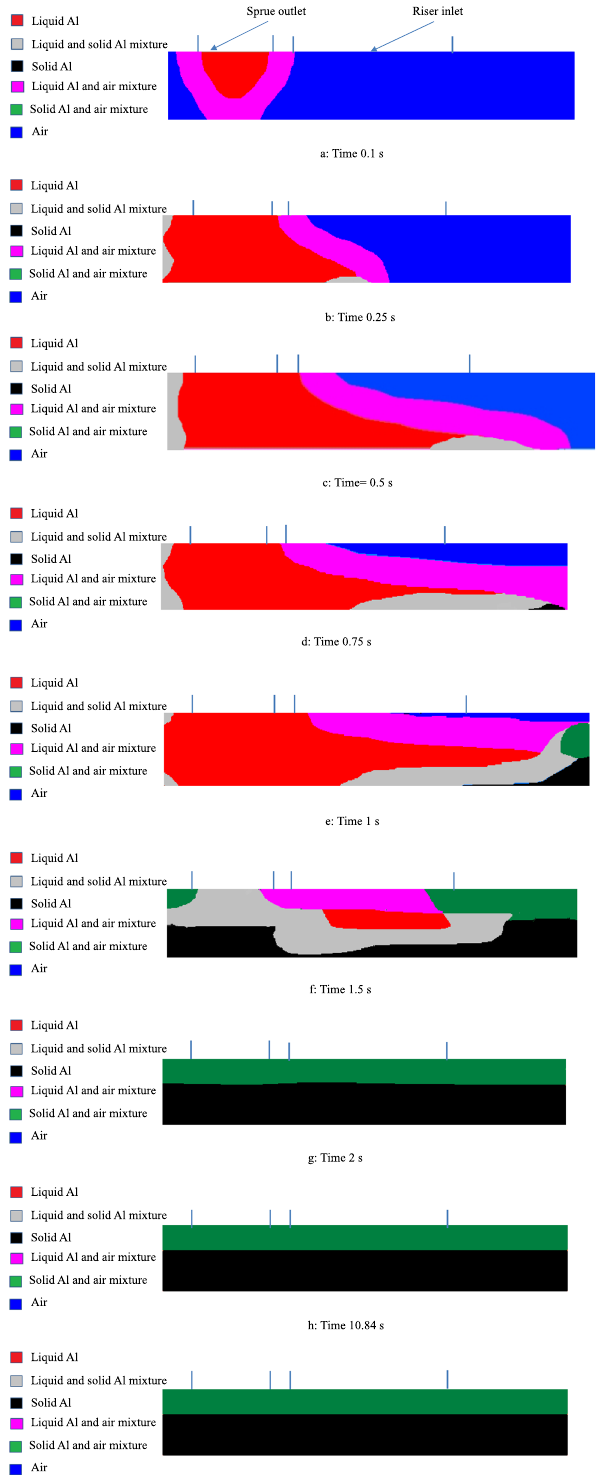
Fig. 8 Simulation of solidification and free surface of mould filling process. a Time 0.1 s. b Time 0.25 s. c Time 0.5 s. d Time 0.75 s. e Time 1 s. f Time 1.5 s. g Time 2 s. h Time 10.84 s. i Time 28.84